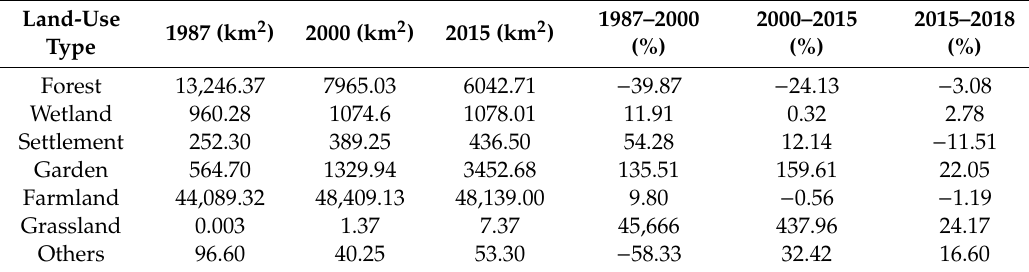
Table 5. The changes of di ff erent land use types in the Mun River basin during